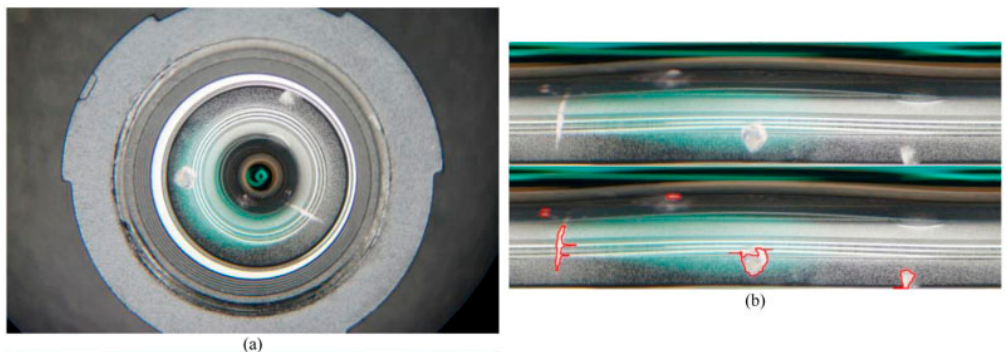
Figure 3. A camera lens with several defects: ( a ) original image and ( b ) converted result based on inspection result and polar coordinate transformation [9].